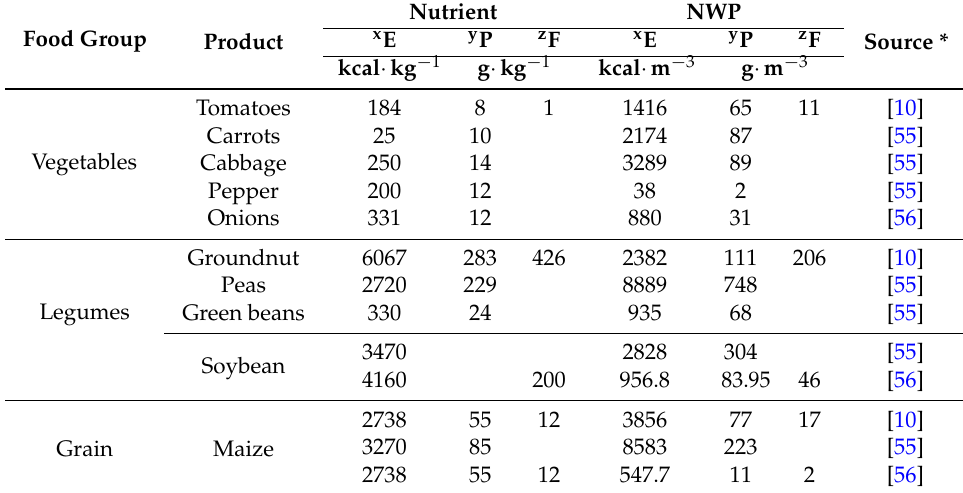
Table 1. Nutrient content and nutritional water productivity (NWP) (macronutrients) (Adapted from